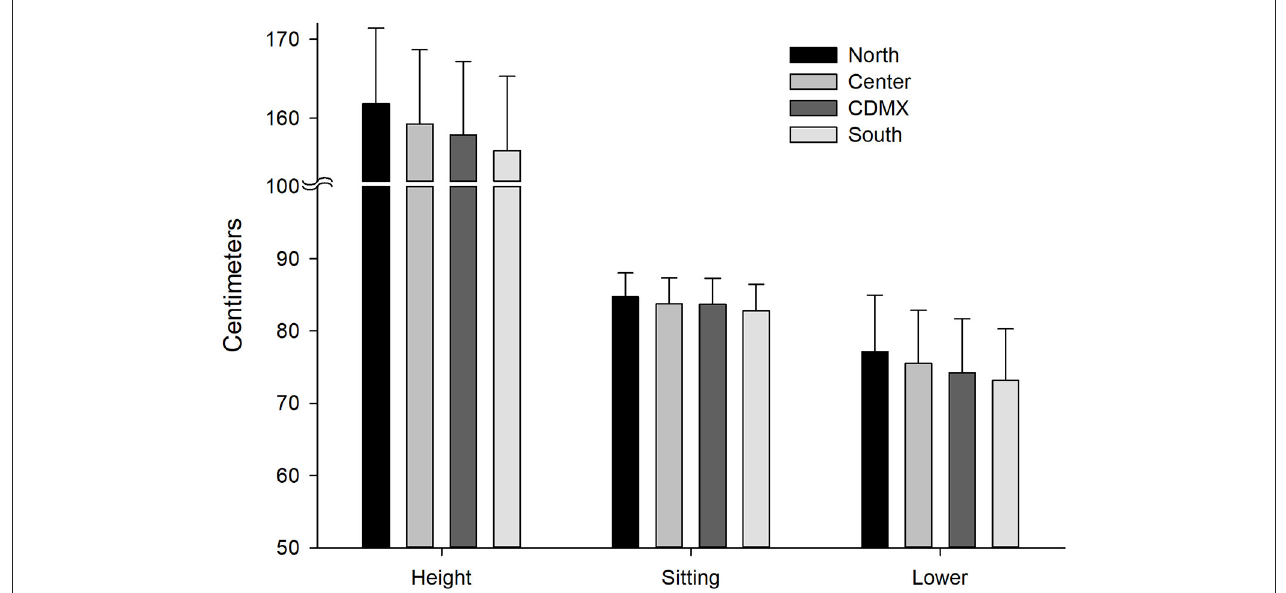
FIGURE 1 | Height measurement standing up, sitting, and the lower body segment. From North to South, height is lower at the expenses of the lower body segment ( p < 0.0001, adjusted by Bonferroni for all regions). Sitting height reflects the upper body segment and shows small differences between regions. Means and standard deviations. Data obtained from the ENEC 1993. CDMX, Mexico City; Sitting, sitting height; Lower, Lower segment of the body (Height-sitting